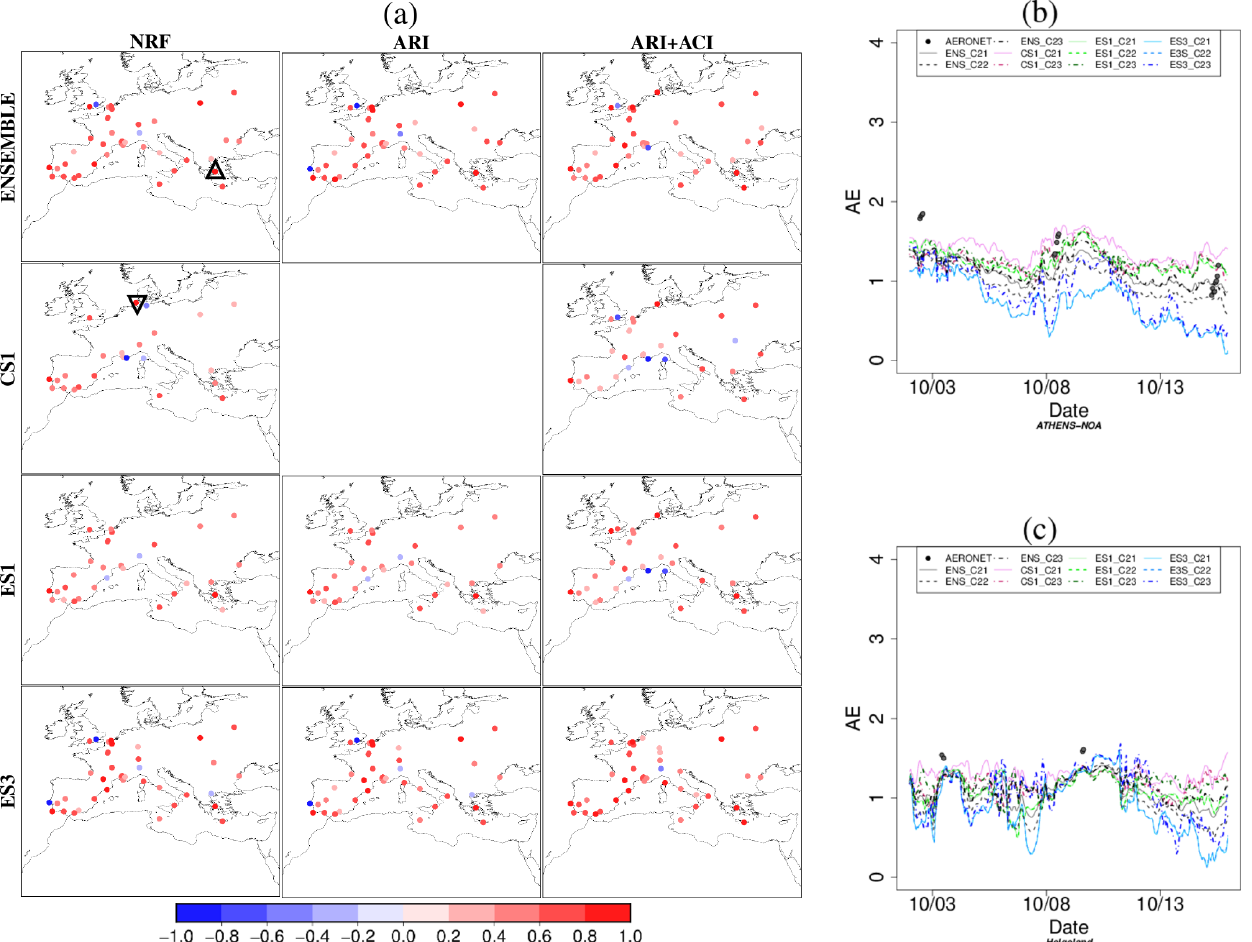
Figure 9. Model–AERONET comparison of AE 440 and 870nm for the Saharan desert dust outbreak case: (a) temporal correlation values at each AERONET station, (b) temporal series at the Athens (located at triangle pointing upwards) and (c) Helgoland (located at triangle pointing downwards)